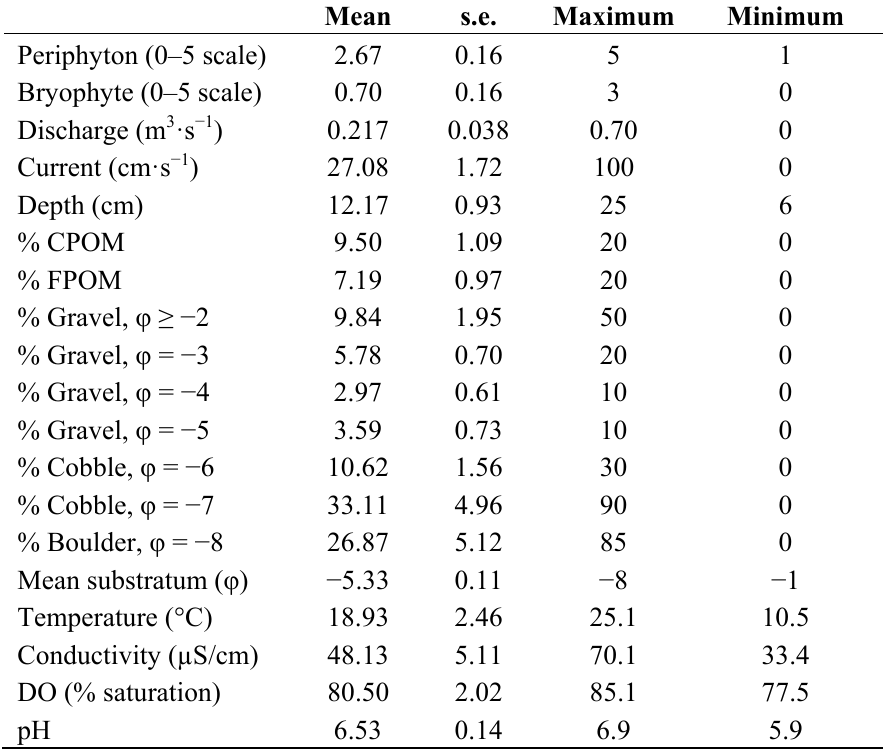
Table 1. Biophysical descriptors of the Yuccabine Creek sampling site (from across all samples, in non-flood conditions). CPOM is coarse particulate organic matter (mainly leaf litter); FPOM, fine particulate organic matter; DO, dissolved oxygen. Periphyton and bryophytes were scored on a 0–5 scale, equivalent to % cover of 0, 1–20, 21–40, 41–80 and >80. Substrata are described by mean size or proportion of sample area in each